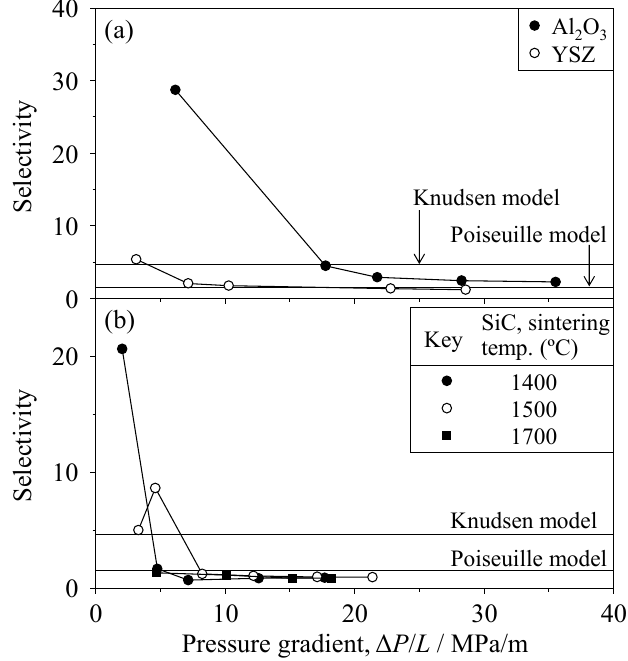
Figure 16. Selectivity (Equation (6)) of ( a ) Al 2 O 3 and YSZ; and ( b ) SiC for the 50 vol % H 2 –50 vol % CO 2 mixed gas.